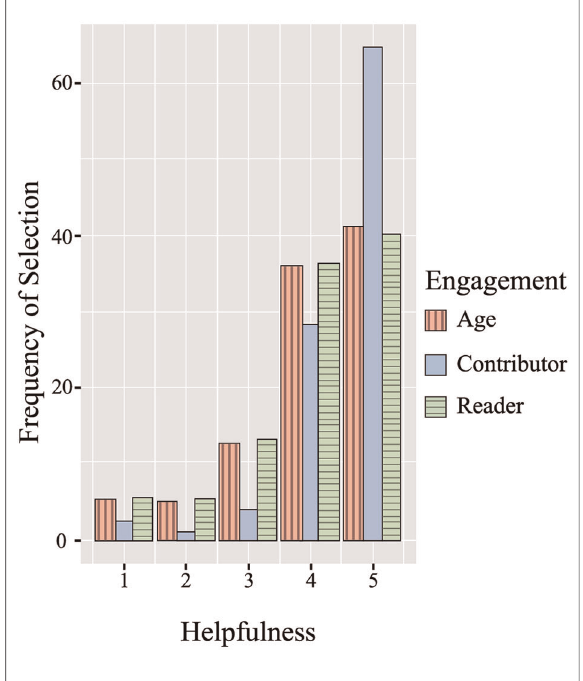
FIGURE 5 Frequency of selection across the fi ve helpfulness scores for each type of